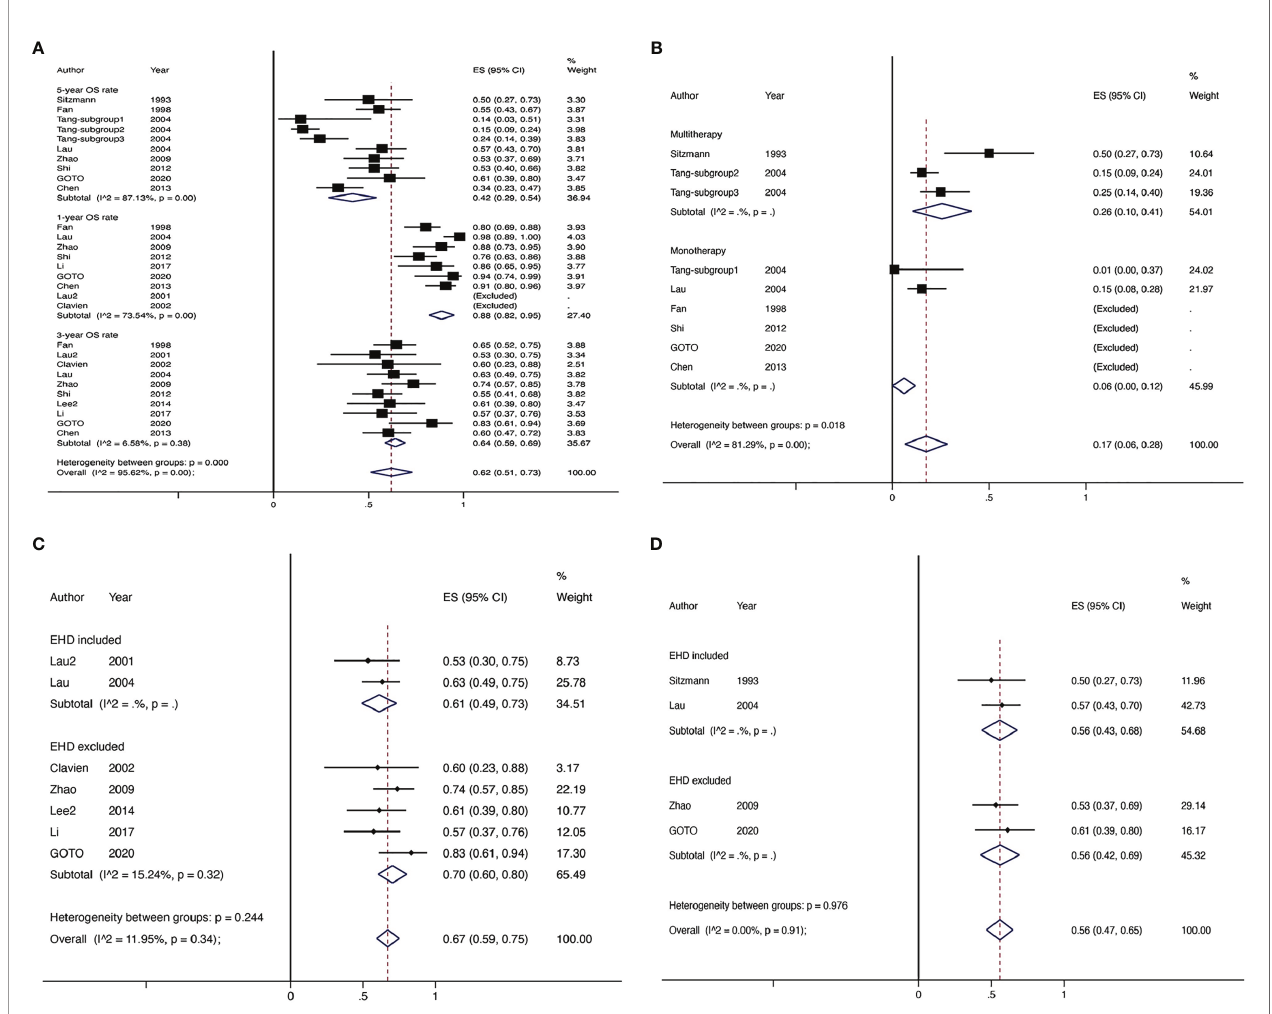
FIGURE 5 | The OS rate of non-comparative studies for HR with downstaging therapies in patients with HCC (A) , the 5-year OS rate of non-comparative studies for HR with downstaging therapies strati fi ed by mono/multitherapy (B) , the 3-year OS rate of non-comparative studies for HR with downstaging therapies strati fi ed by EHD included/excluded (C) , the 5-year OS rate of non-comparative studies for HR with downstaging therapies strati fi ed by EHD included/excluded (D) . EHD, extrahepatic